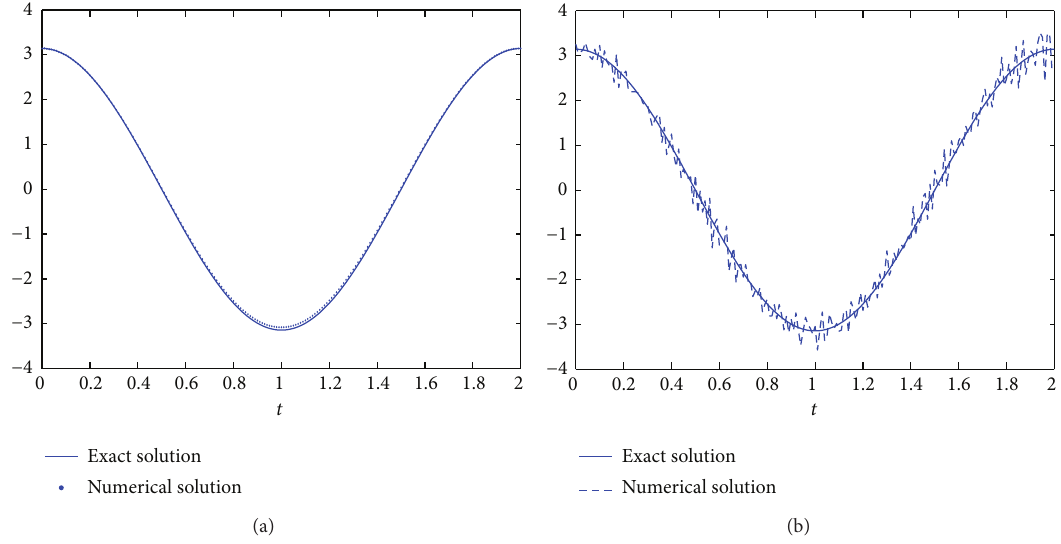
̂𝑓(𝑡) with 𝑞 = 0.001 , (a) MLS and (b) FDM.